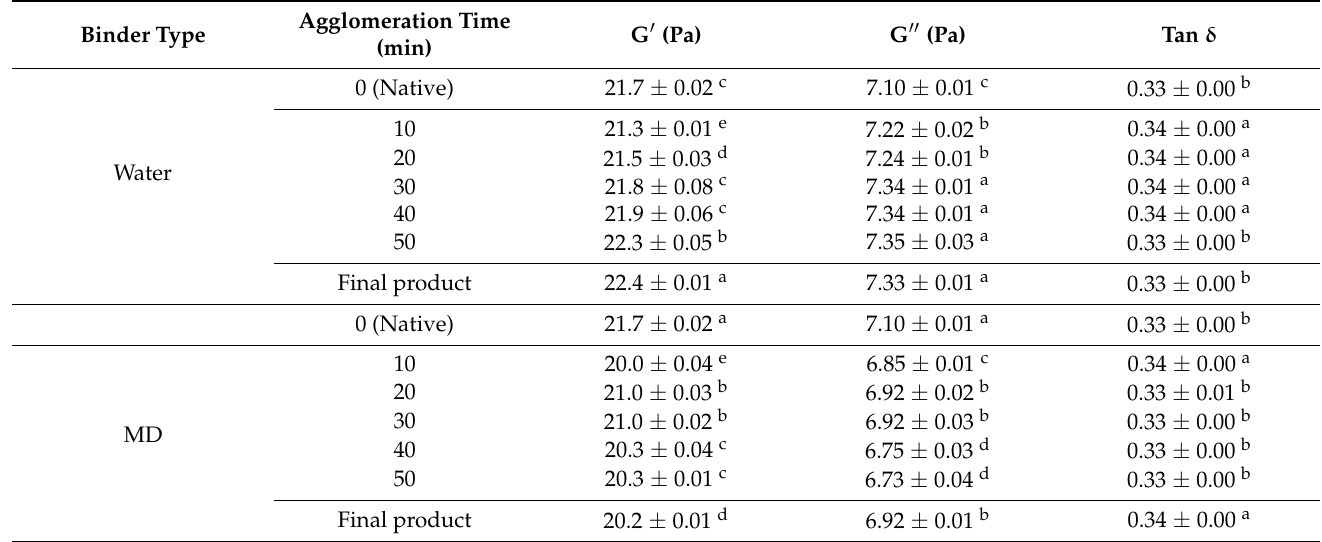
Table 2. Values of dynamic rheological parameters (G (cid:48) , G (cid:48)(cid:48) , and tan δ at 6.28 rad s − 1 ) of XG agglomer- ates with different binders (water and MD) as a function of agglomeration